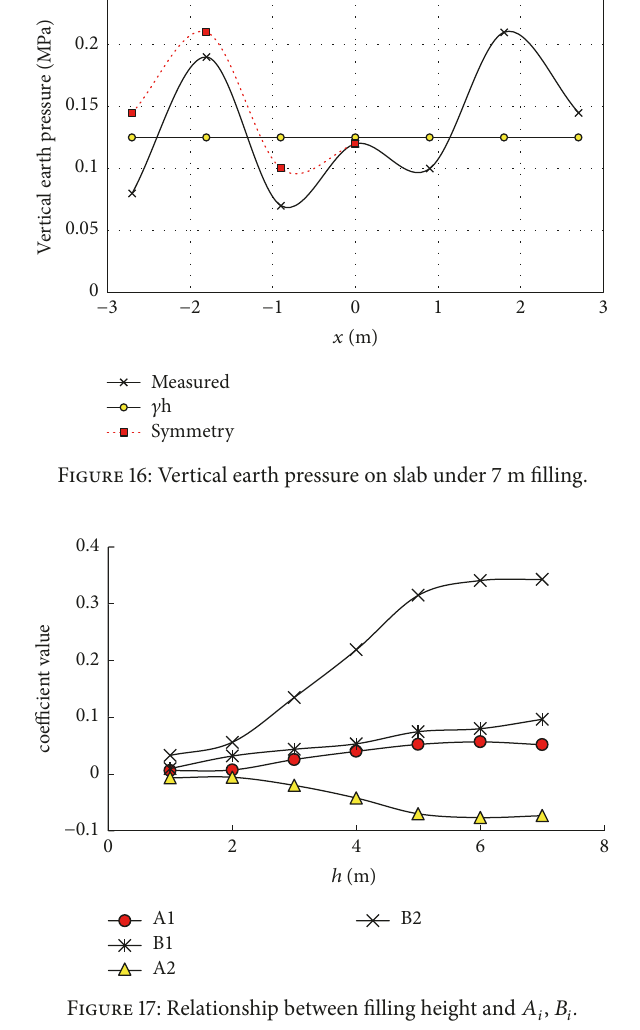
Table 4: Vertical pressure coefficient on slab.